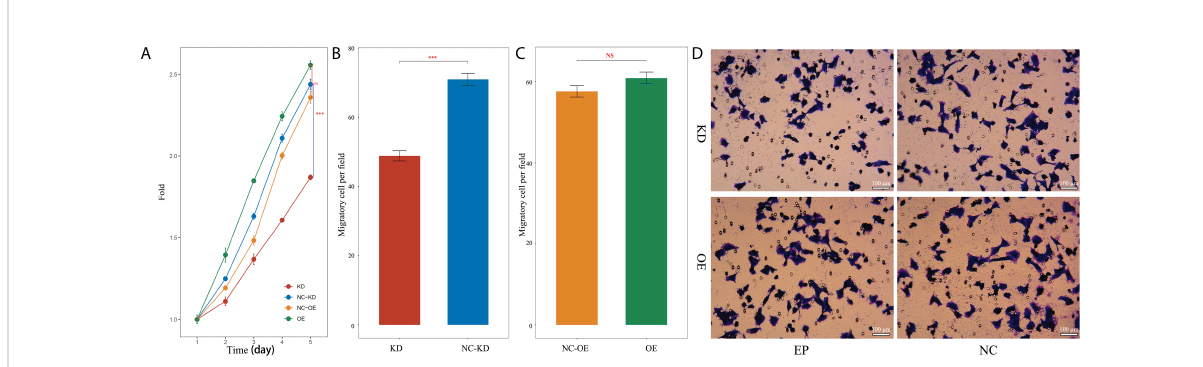
FIGURE 9 Effects of knockdown and overexpression of nectin-1 on proliferation and migration of hepatoma cells. (A) Effects of knockdown and overexpression of nectin-1 on the proliferation of hepatoma cells. (B) Effect of knockdown of nectin-1 on the migration of hepatoma cells. (C) Effect of overexpression of nectin-1 on the migration of hepatoma cells. (D) Cell migration picture of nectin-1 knockdown and overexpression. ***P<0.01; ns, no signi fi